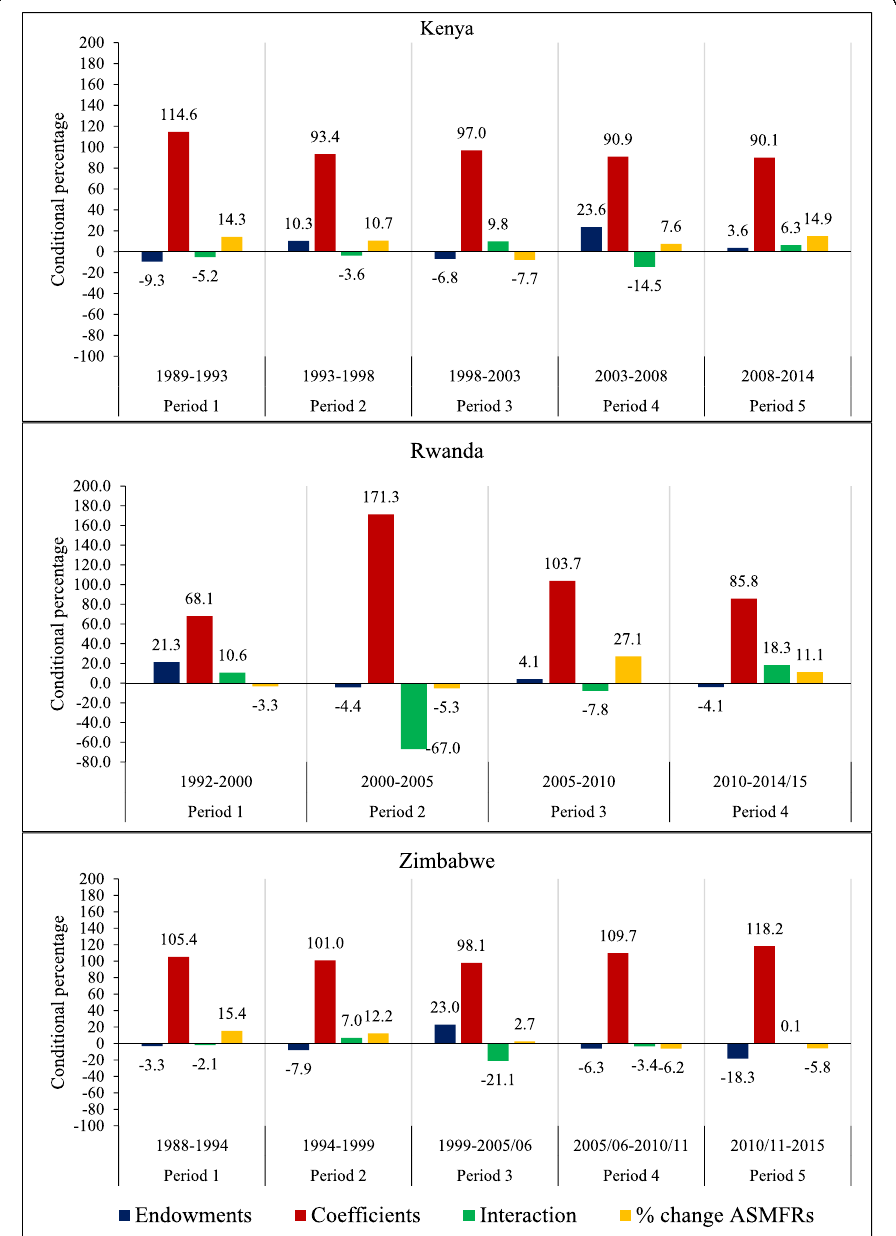
Fig. 3 Aggregate decomposition results and inter-survey percentage-points differences in the mean of